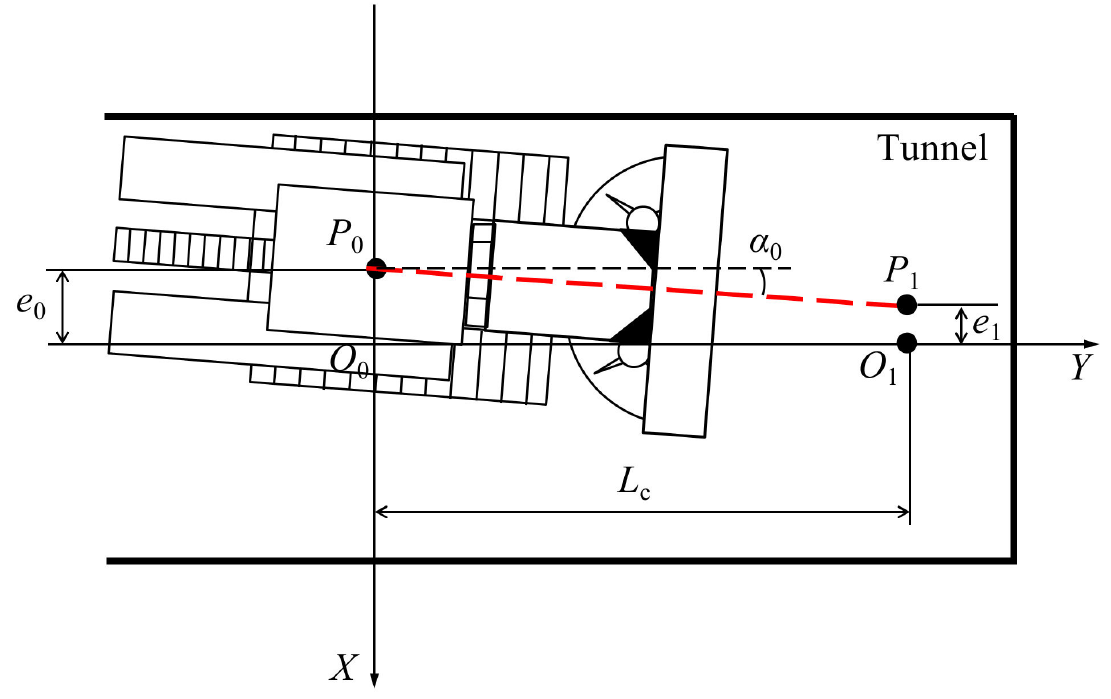
Figure 3. The starting point and endpoint when | e 1 | ≤ | e 0